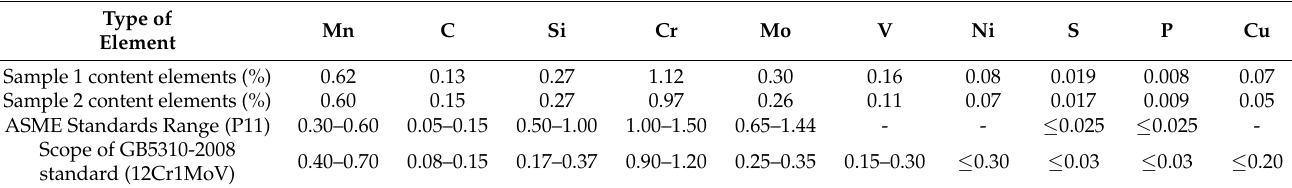
Table 1. Sample 1 and Sample 2 chemical analysis results mass